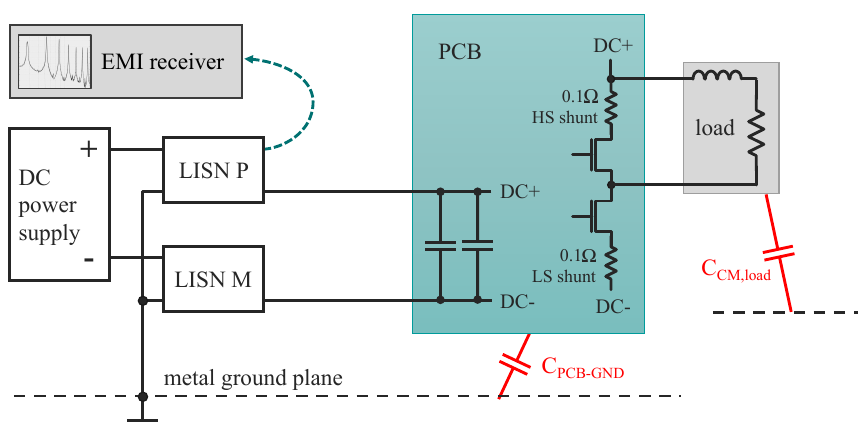
Figure 1. Photo of the DUT PCB top and bottom side.